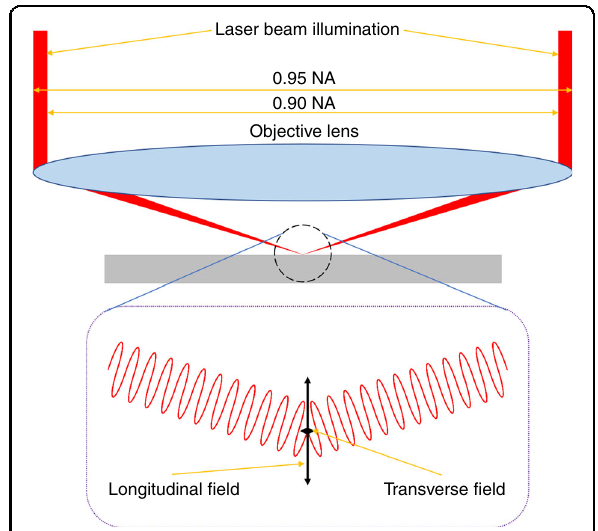
Fig. 6 Schematic of the longitudinal fi eld